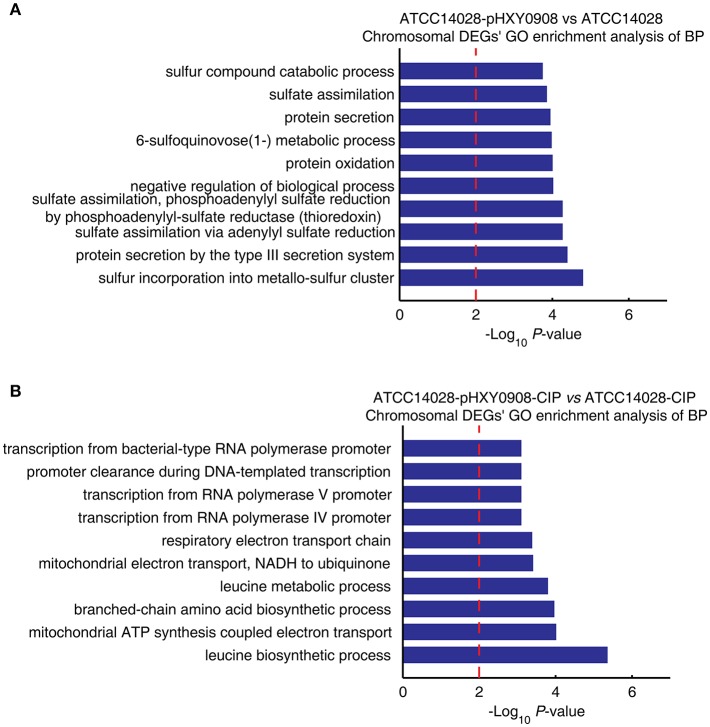
The chromosomal DEGs GO enrichment analysis of biological processes. (A) ATCC14028-pHXY0908 vs. ATCC14028 and (B) ATCC14028-pHXY0908-CIP vs. ATCC14028-CIP (B). The top 10 biological processes are shown. The dotted red line indicates the P-value threshold of 0.01.